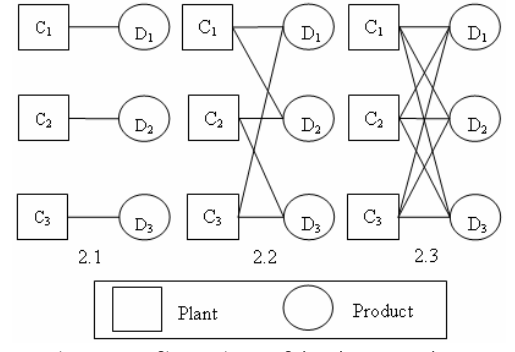
Fig. 2. Configurations of the three-product, three-plant